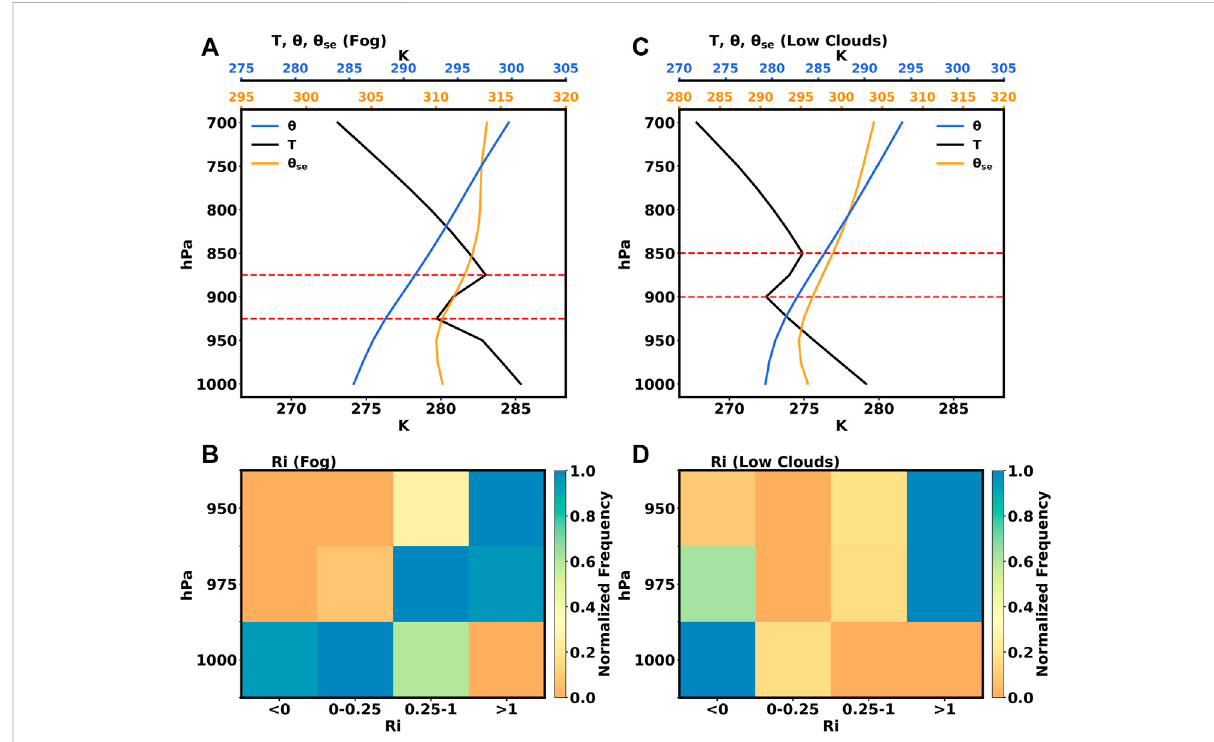
FIGURE 5 Composite pro fi les and the bulk Richardson number frequency distribution concurrent with fog (A,B) and low clouds (C,D) : temperature ( T , black line, K), potential temperature θ ( θ , blue line, K), saturated equivalent potential temperature θ se ( θ se , orange line, K), and the bulk Richardson number ( Ri , shaded). The red dashed lines denote the inversion